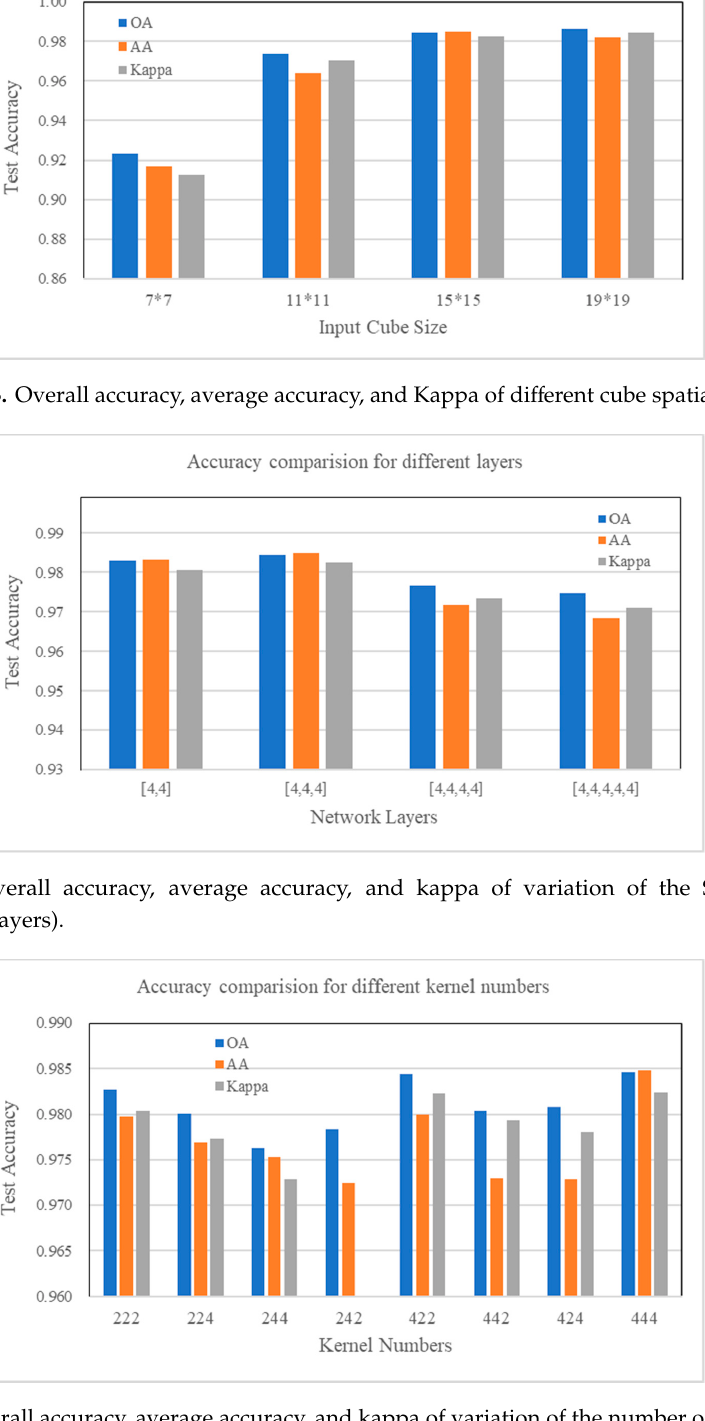
Figure 15. Overall accuracy, average accuracy, and kappa of variation of the number of the